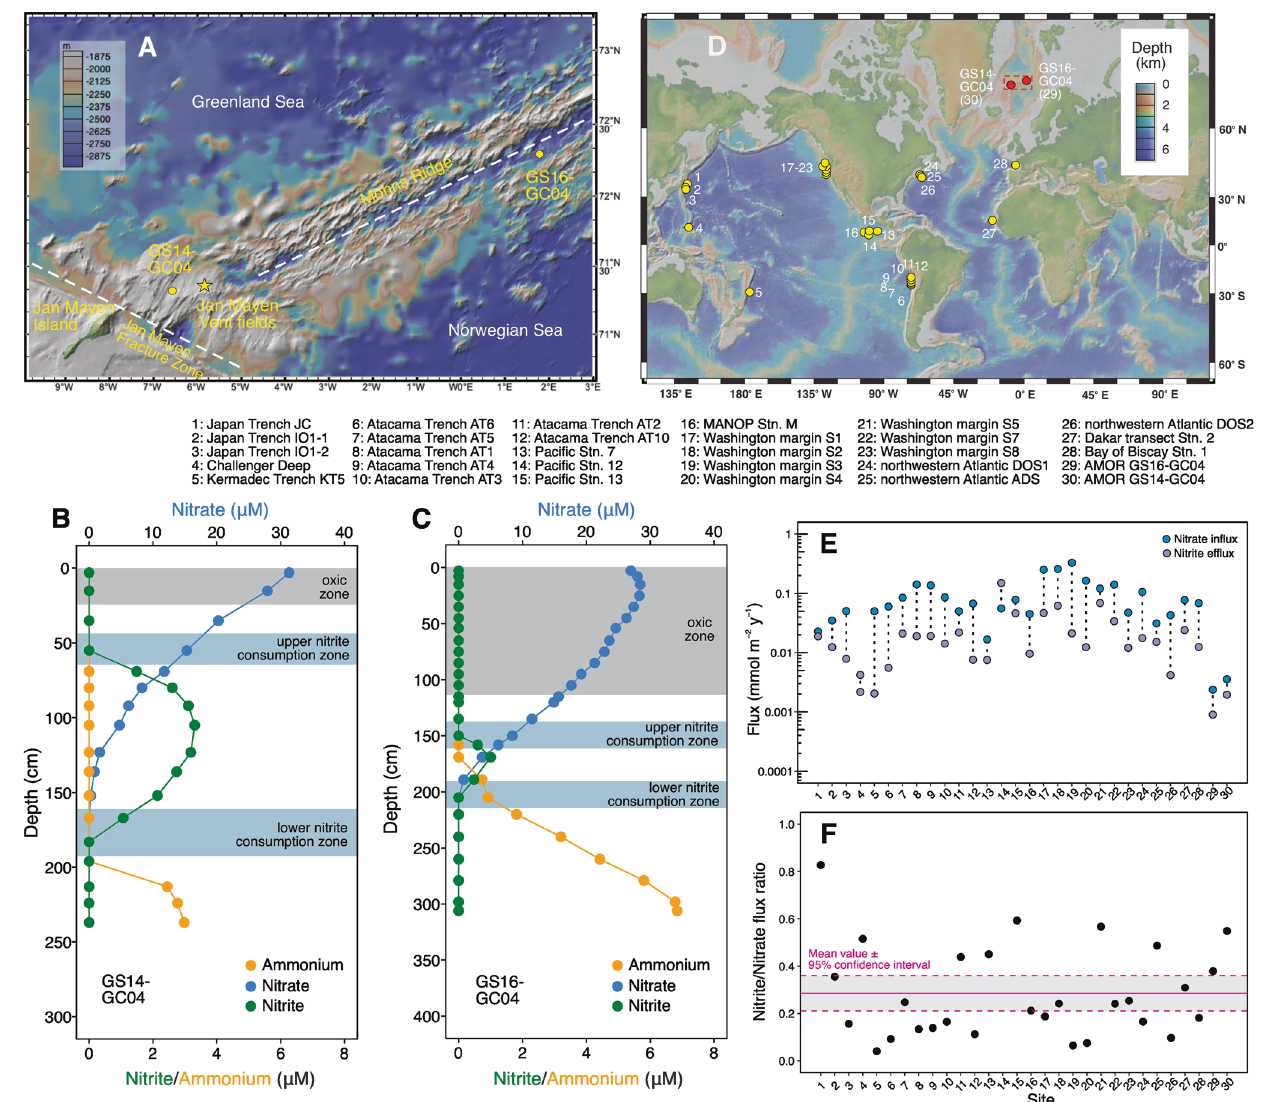
Fig. 1 The occurrence of nitrite accumulation in sediment porewater of the Arctic Mid-Ocean Ridge and other locations. A Bathymetric map showing two coring sites (GS14-GC04 investigated in this study and GS16-GC04 investigated in ref. [13]) in the Arctic Mid-Ocean Ridge area where nitrite accumulation was observed. Also highlighted are the Jan Mayen Fracture Zone and the Mohns Ridge, as well as the Jan Mayen hydrothermal vent fi eld (yellow star). Accumulation of nitrite in the two AMOR sediment cores. Porewater pro fi les of nitrate, nitrite, and ammonium of ( B ) GS14-GC04 and ( C ) GS16-GC04 are shown. The oxic zones and two (upper and lower) net nitrite consumption zones are highlighted by horizontal bands. D Sediment locations where nitrite accumulation in the sediment porewater was detected. The two AMOR sites are shown in red circles, while other sites are shown in yellow circles (See Fig. S3 for the porewater nitrite and nitrate pro fi les of individual sites). Maps in ( A ) and ( D ) were generated with GeoMapApp v. 3.6.14 (www.geomapapp.org), using the default Global Multi-Resolution Topography Synthesis basemap. ( E ) Nitrate in fl ux and (combined upward and downward) nitrite ef fl ux in the nitrate-depletion zones of the 30 sediment sites shown in ( D ). The paired fl uxes for each site are connected with a black dotted line. F Calculated nitrite/nitrate fl ux ratio for the individual sites. The horizontal line denotes the mean value of the 30 sites, while the dashed lines represent the 95% con fi dence